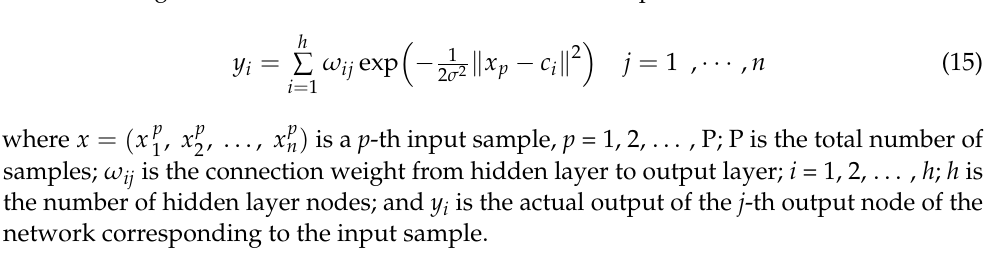
Figure 6. RBF model